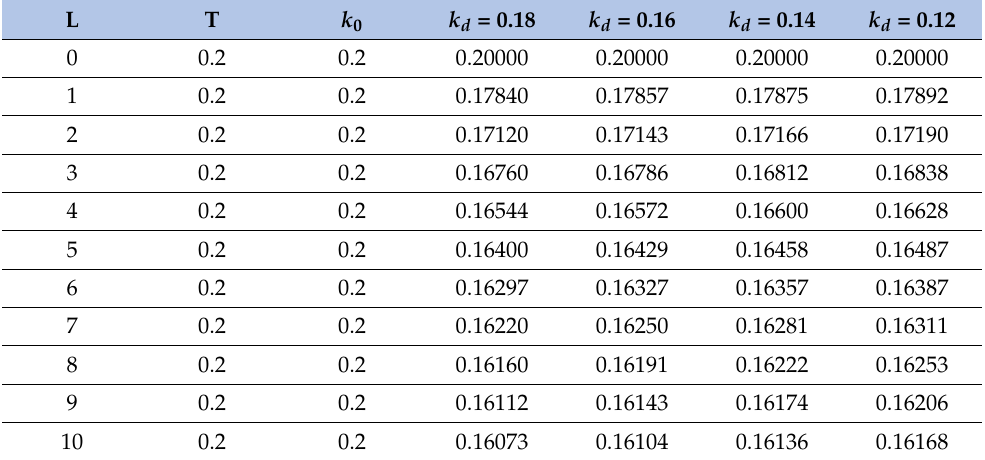
Table A3. Dependence of WACC on leverage level L at k 0 = 0.2, p = 12 and different k d = 0.18; 0.16; 0.14; 0.12.